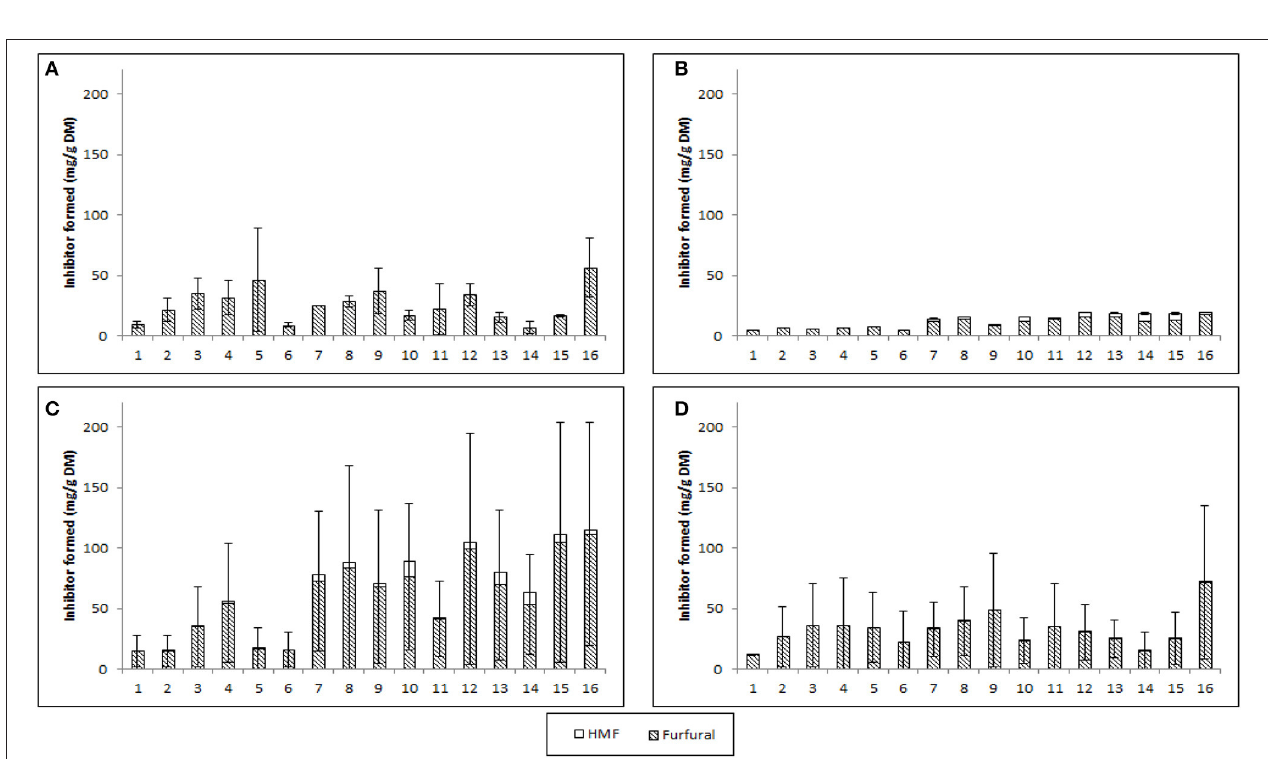
FIGURE 3 | Furfural and 5-Hydroxymethyl-furfural produced through SE-PT with feedstock [ (A) wheat straw, (B) Willow, (C) corn stover, (D) Miscanthus × giganteus]. Vertical bars represent the standard deviation of the mean n = 2.